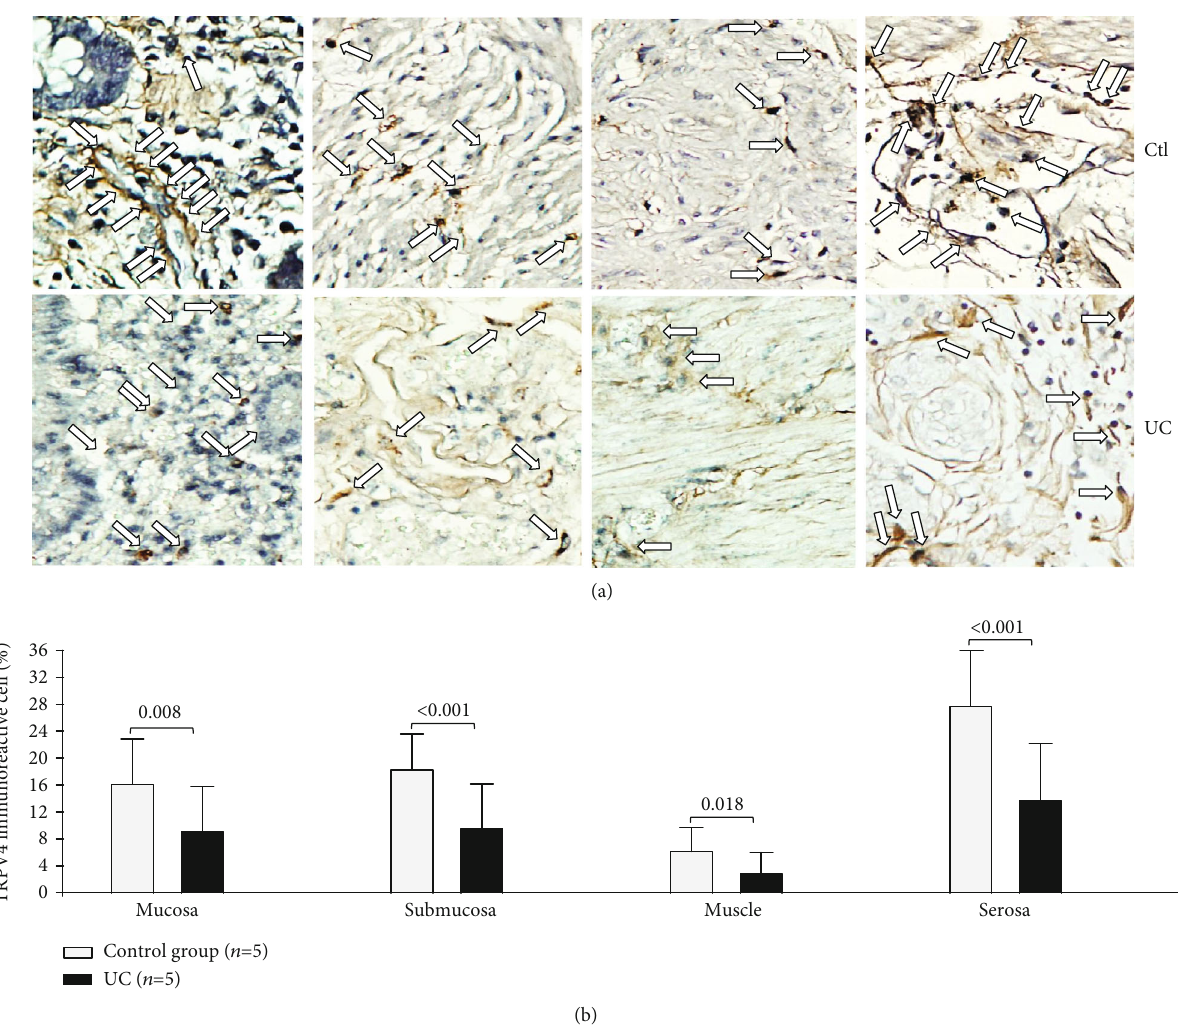
Figure 4: Protein expression of TRPV4 in intestinal tissue from patients with UC and controls. TRPV4 protein expression in slides with colonic tissue obtained from patients with severe ulcerative colitis and nonin fl amed colonic tissue. (a) Immunoperoxidase photomicrographs of ulcerative colitis (lower panel, n = 5 ) and non-IBD colonic tissue (control; upper panel, n = 5 ). Arrows indicate TRPV4 immunoreactive cells in the mucosa, submucosa muscular, and serosa layers. Original magni fi cation was × 320. (b) TRPV4-producing cell percentage in nonin fl amed colonic tissues (control, n = 5 ) and active UC patients ( n = 5 ) is shown in